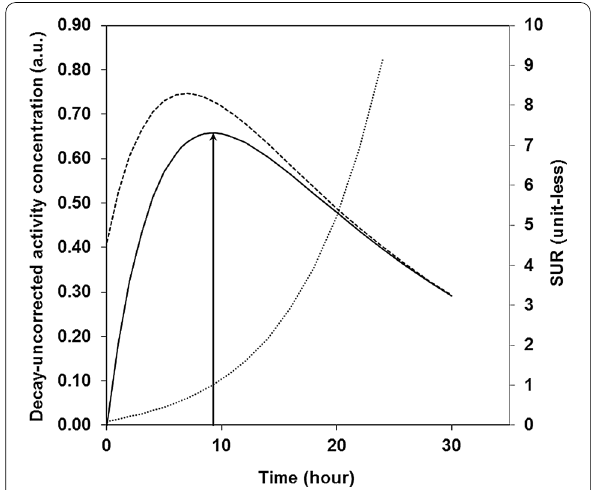
Fig. 1 Decay-uncorrected activity concentration versus time of trapped (full) and of tumor (dashed) [ 64 Cu]Cu-SARTATE; SUR versus time (dotted). Peak time of decay-uncorrected trapped-tracer activity concentration is